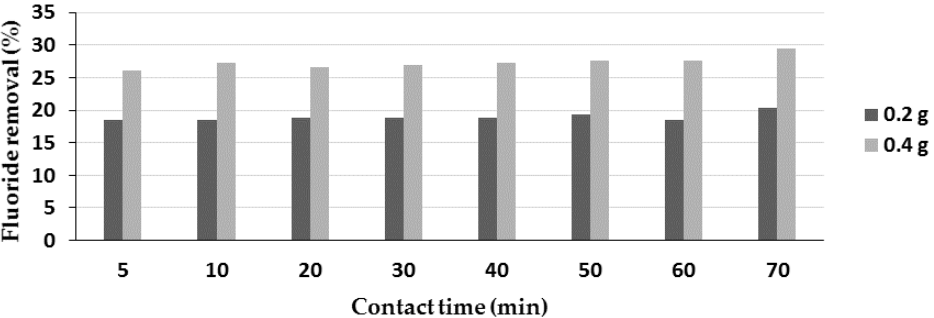
Figure 5. Optimisation of contact time (0.2 and 0.4 g/50 mL, 25 °C, 200 rpm).